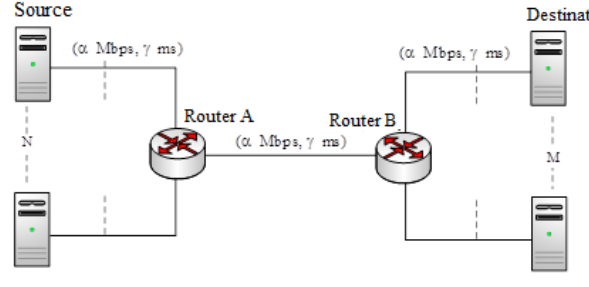
Figure 16. Network model simulating multiple receivers